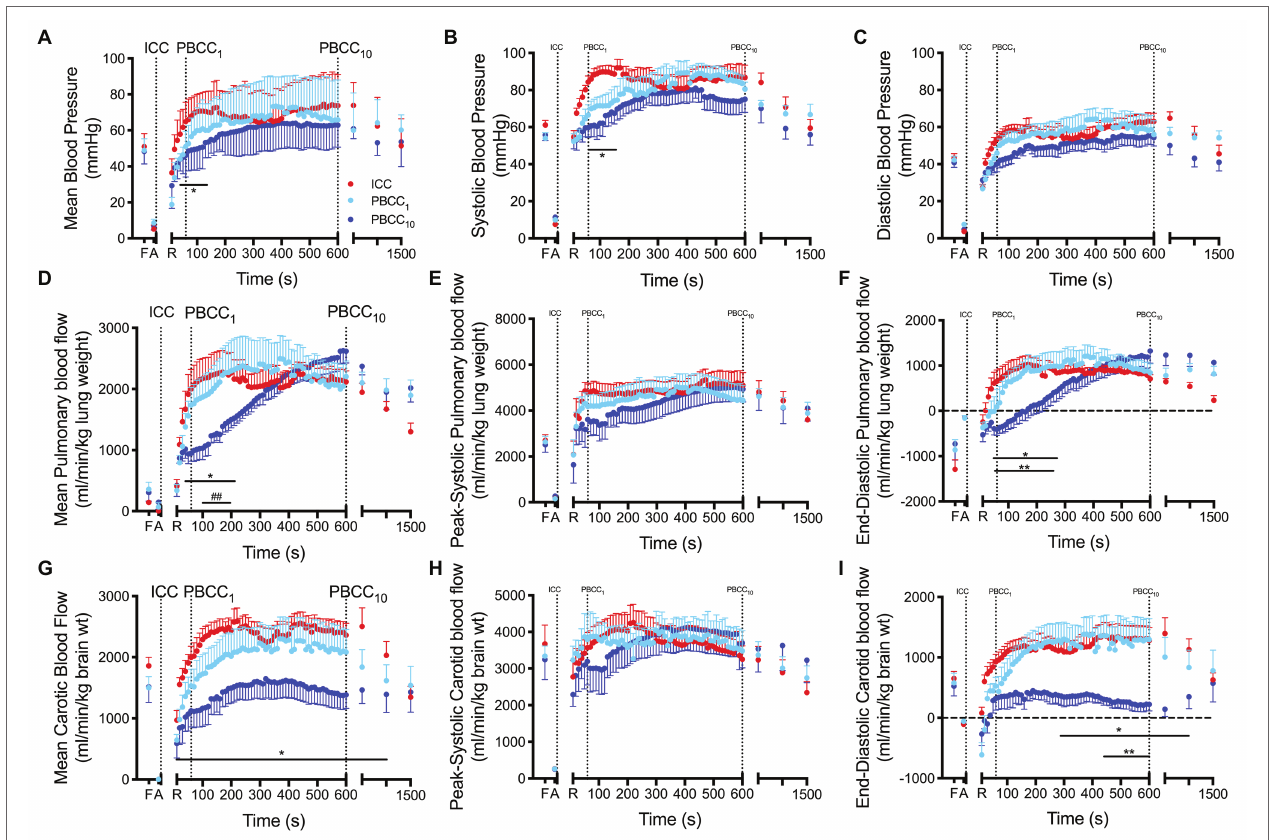
FIGURE 4 | (A–C) Mean, systolic and diastolic arterial blood pressure, (D–F) mean, peak-systolic and end-diastolic pulmonary blood flow and (G–I) mean, peak- systolic and end-diastolic carotid arterial blood flow measured prior to delivery (fetal, F), and at the end of the asphyxial period (A), and upon spontaneous return of circulation (R) in ICC (red), PBCC 1 (light blue), and PBCC 10 (dark blue) lambs. *indicates significant difference ( p < 0.05) between PBCC 1 and ICC lambs at that time point. **indicates significant difference ( p < 0.05) between PBCC 1 and PBCC 10 lambs at that time point. ## indicates trend ( p < 0.07) between PBCC 1 and PBCC 10 lambs at that time point. Data are mean ±